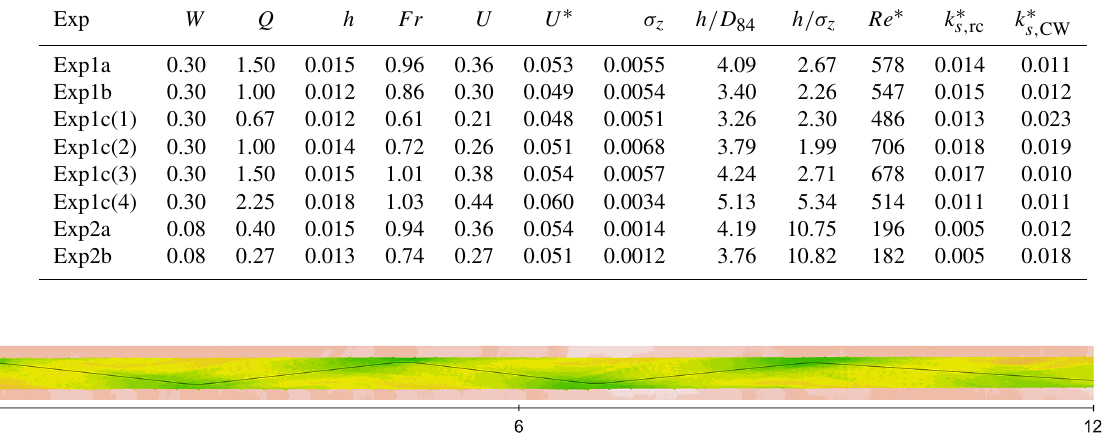
Figure 3. DEM of the pool–bar–riffle channel morphology at the end of Experiment 1a, with estimated position of the thalweg. Zero represents the downstream extent of the